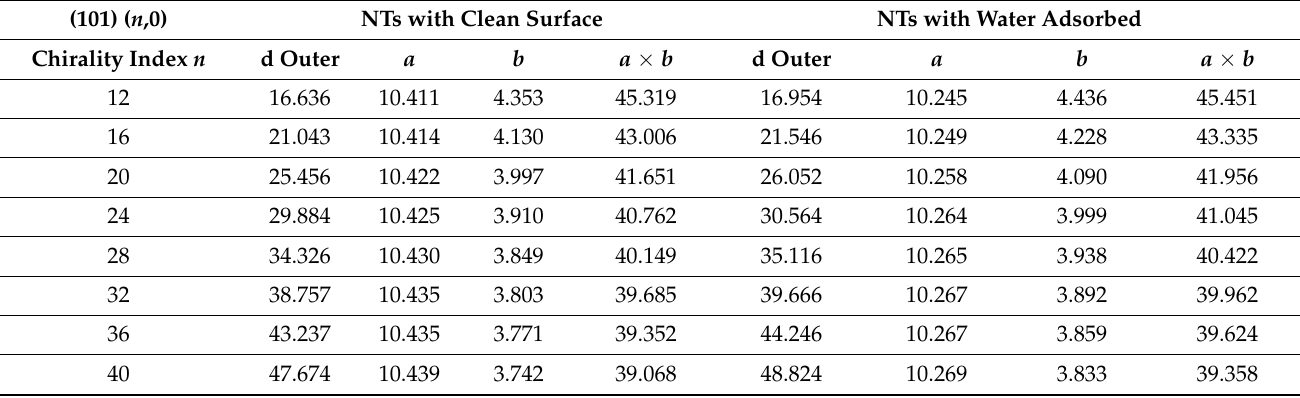
Table 4. Parameters of 6-layered (001) (0, n ) TiO 2 NTs, simulated with and without water. The lattice parameter corre- sponding to the NT axis is denoted with a , d stands for outer diameter, b —for outer b constant along NT circumference, and a × b —their product.